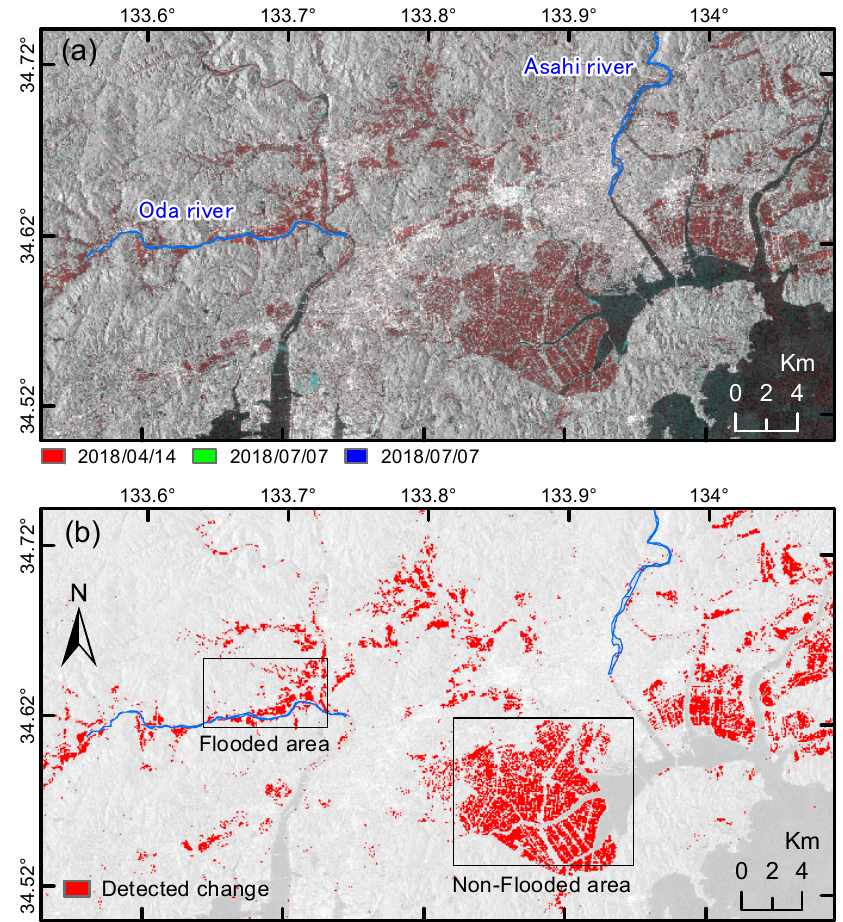
Figure 2. ( a ) Color composite of pre- and post-event ALOS-2 SAR images. The inset denotes the location of the study area in the western Japan. ( b ) Thresholding-based water body identification. The black rectangles denote confirmed flooded and non-flooded agriculture